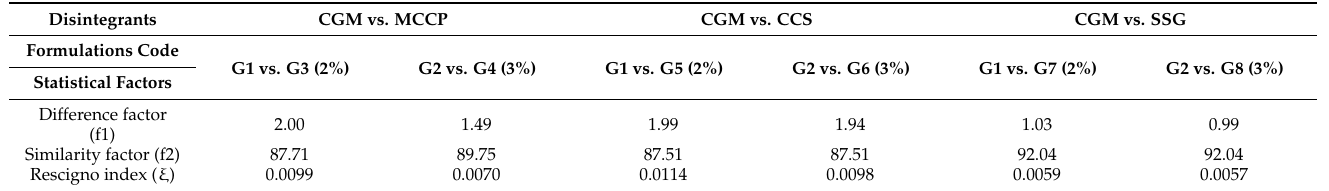
Table 12. Statistical factors of CGM compared with MCCP, CCS and SSG as disintegrating agents.